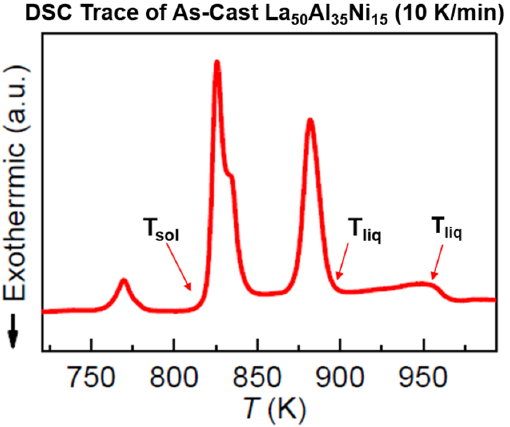
Figure 13. DSC trace of as-cast La 50 Al 35 Ni 15 BMG . The DSC curve obtained at a heating rate of 10 K/min. Liquidus temperature (T liq ) indicated by red arrows. The two liquidus temperatures (T n+ ) and solidus temperature (T sol ) are added. Reprinted from ref. [20], Figure S1.